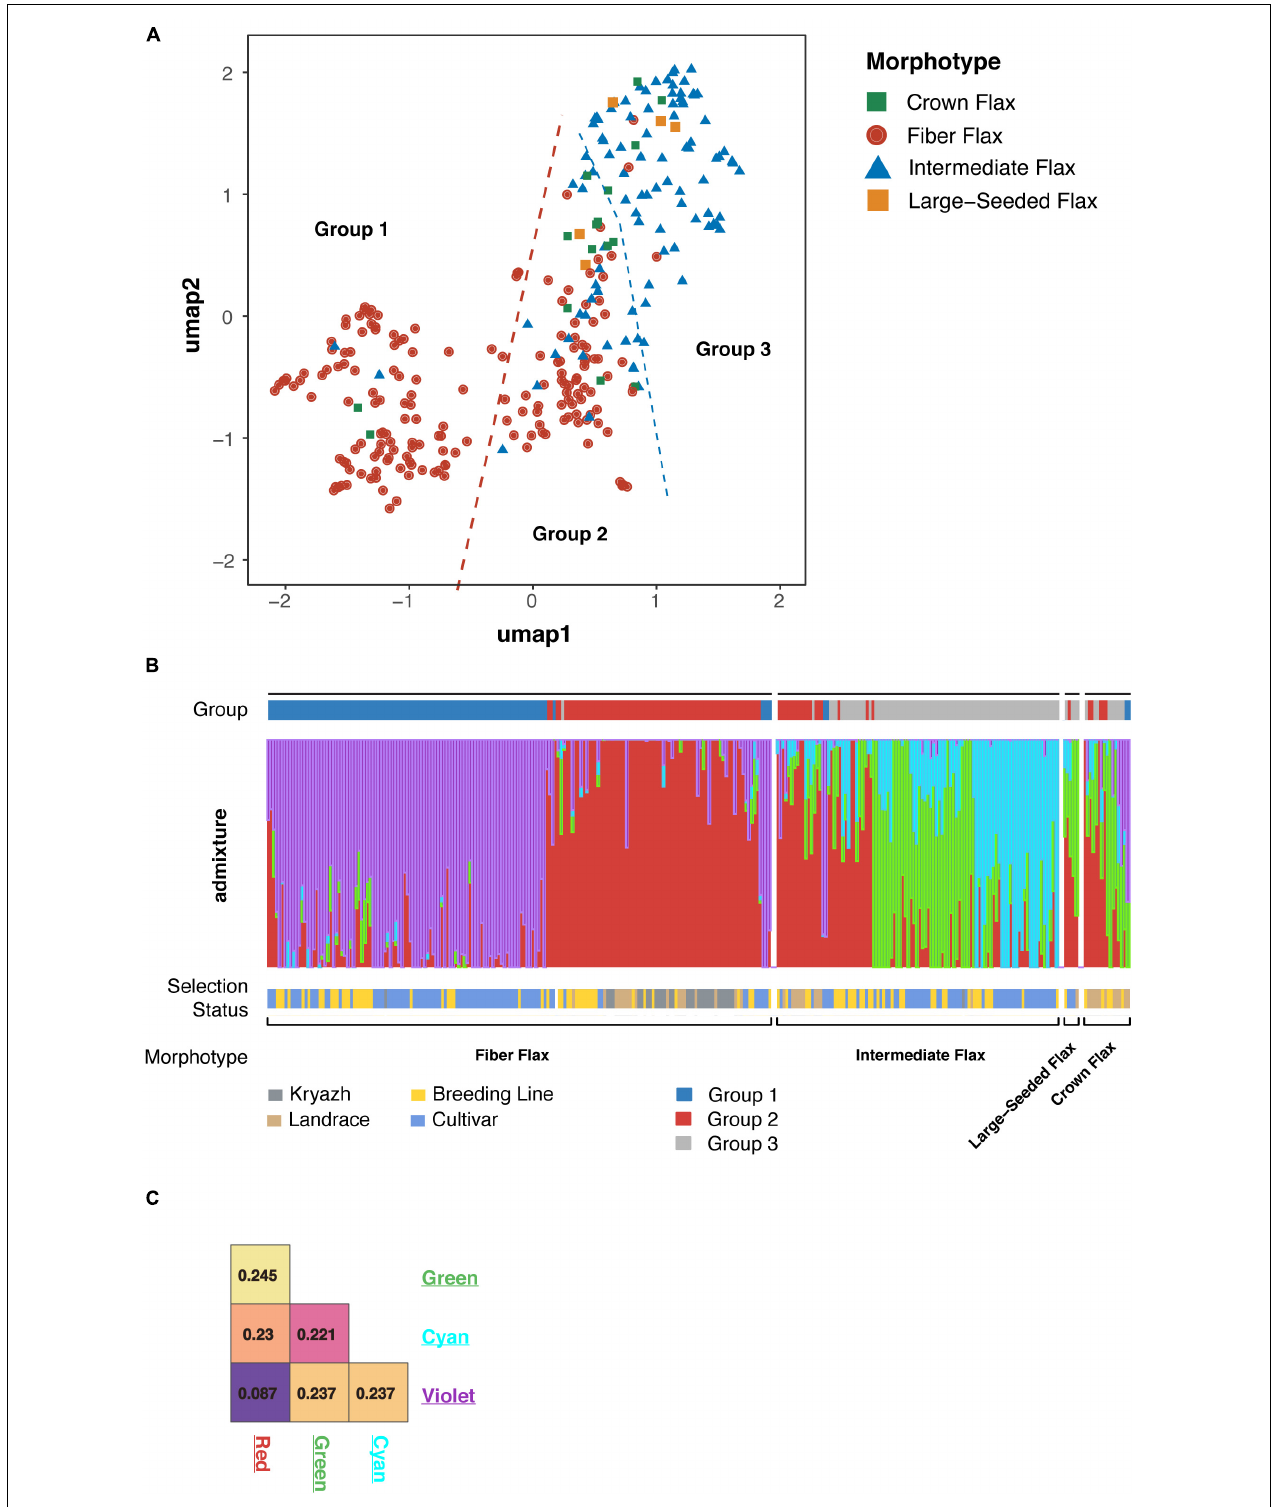
FIGURE 2 | Population structure of flax accessions. (A) Visualization of flax accession clustering using Uniform Manifold Approximation and Projection (UMAP) algorithm. Fiber flax accessions are shown as red dots, intermediate flax accessions are blue triangles, crown flax and large-seeded accessions are presented as green and yellow squares, respectively. (B) The ADMIXTURE graph identified four subpopulations and supports subdivision of sequenced accessions into three groups. (C) Subpopulation differentiation calculated with Fst statistics. Color labels correspond with the populations revealed by admixture.